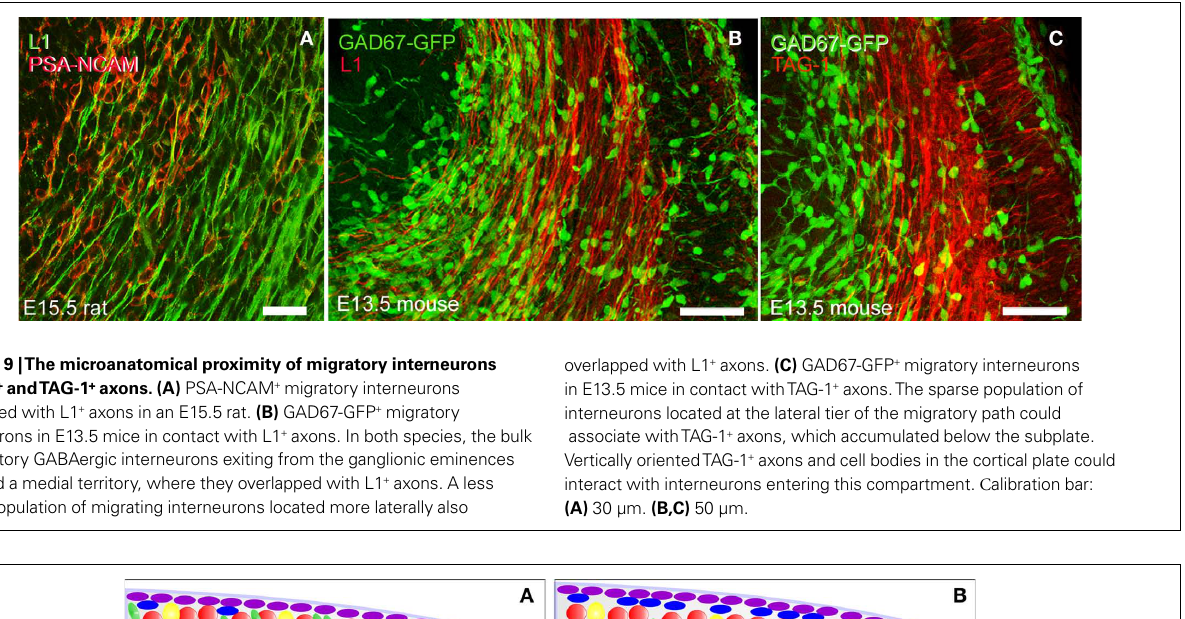
overlapped with L1 + axons. (C) GAD67-GFP + migratory interneurons in E13.5 mice in contact with TAG-1 + axons. The sparse population of interneurons located at the lateral tier of the migratory path could associate with TAG-1 + axons, which accumulated below the subplate. Vertically oriented TAG-1 + axons and cell bodies in the cortical plate could interact with interneurons entering this compartment. C alibration bar: (A) 30 µm. (B,C) 50 µm.